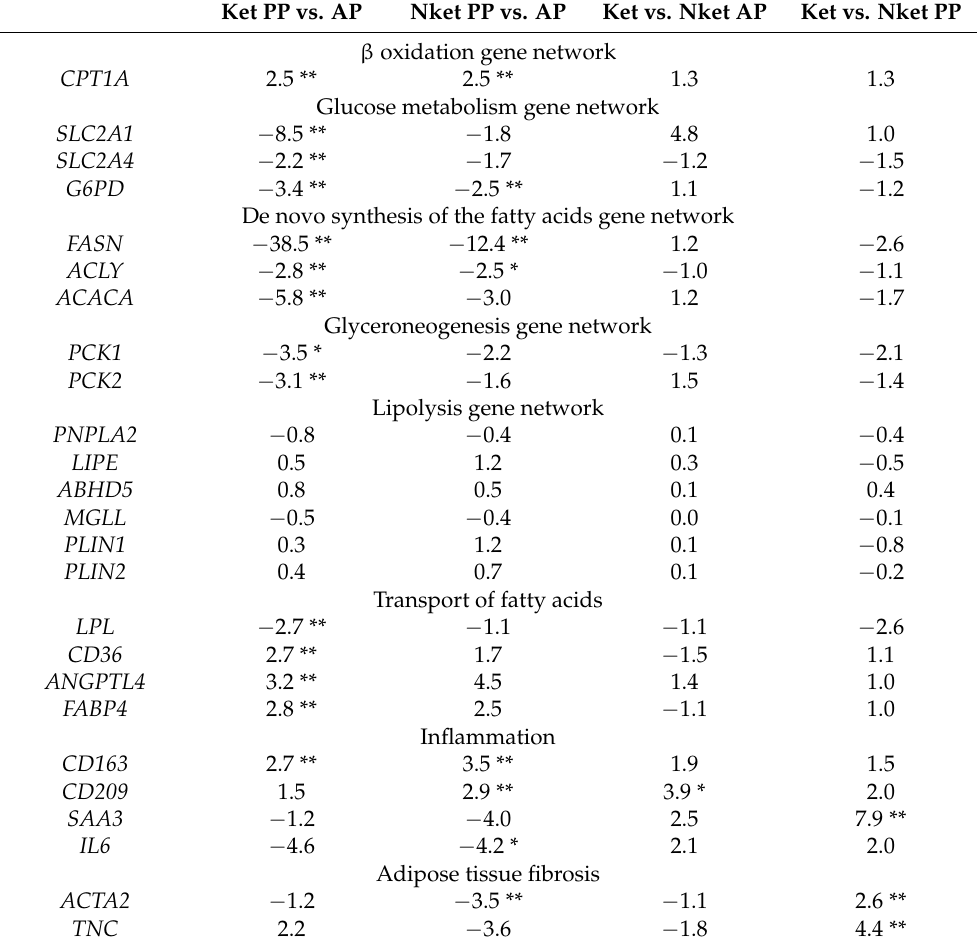
Table 1. DEGs and fold change (FC) of sWAT transcriptome involved in β oxidation, glucose metabolism, de novo of the fatty acid synthesis, glyceroneogenesis, lipolysis, fatty acid transport, in- flammation, and tissue fibrosis between d − 21 antepartum (AP) and d +10 post-partum (PP) in the ke- totic cows (Ket = 8, BHBA ≥ 1.4 mmol/L) and the non-ketotic cows (Nket = 6, BHBA < 1.4 mmol/L); * indicates Padj < 0.05, ** indicates Padj < 0.01. Ket PP vs. AP Nket PP vs.